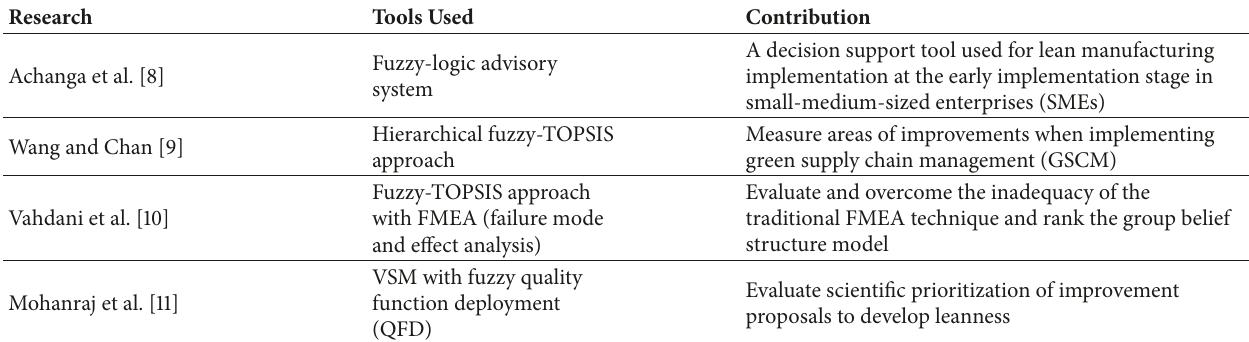
Table 1: Research contribution for integrated VSM with fuzzy